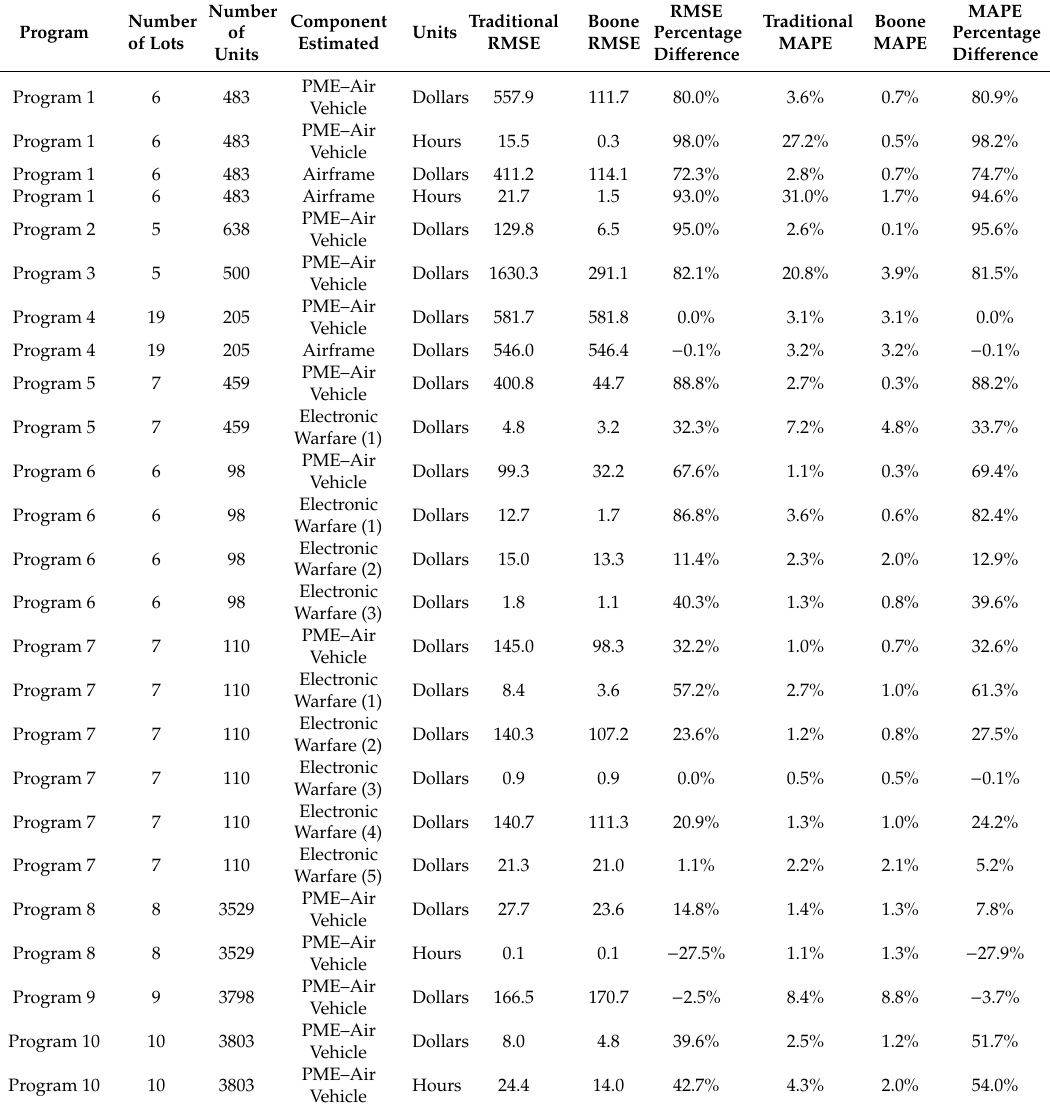
Table A1. Error Comparison using Cumulative Average